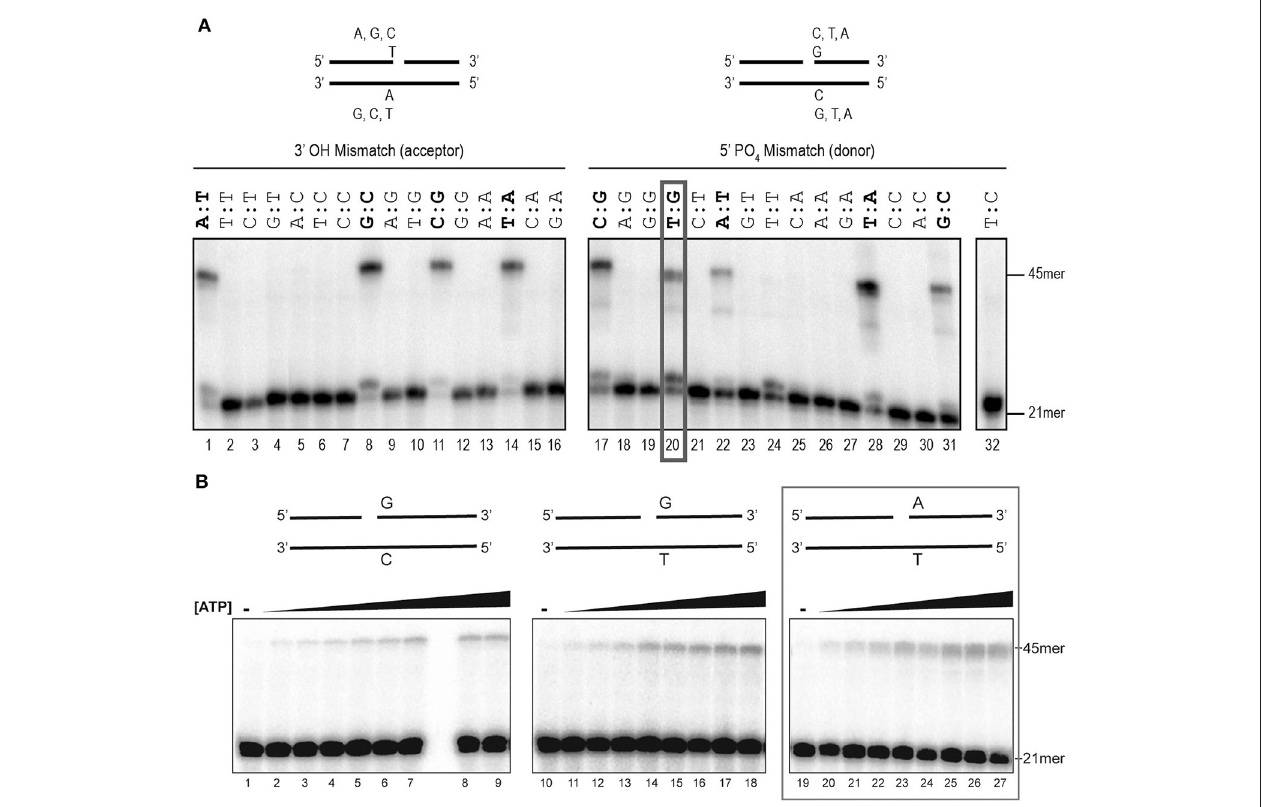
FIGURE 1 | Assessment of rEhDNAligI fidelity on nicked double stranded DNA mismatches. (A) Schematic representation of the different substrates used to evaluate DNA ligation fidelity. The mismatches were evaluated at the 3 ′ -OH (acceptor) and 5 ′ -PO 4 (donor) using a combination of 16 different oligonucleotides. Each substrate varies only one base at a time at the 3 ′ -OH (acceptor, lanes 1–16) or 5 ′ -PO 4 (donor, lanes 17–32). Of the 16 combinations at each end, 4 of them do not have any mismatch and are marked in red, while 24 substrates have an error in base pairing. The red ox shows the only mismatched substrate ligated by EhDNAligI. (B) Steady-state kinetics of EhDNAligI on the G:T mismatch at different concentrations of ATP. Lanes 1–9 show EhDNAligI activity at different ATP concentrations in comparison to canonical G:C substrate, lanes 10–18 monitored ligase activity with a mismatched G:T substrate, lanes 19–27 indicate activity with the canonical A:T substrate. The 21mer substrate and the 45mer ligation products are marked with arrows.